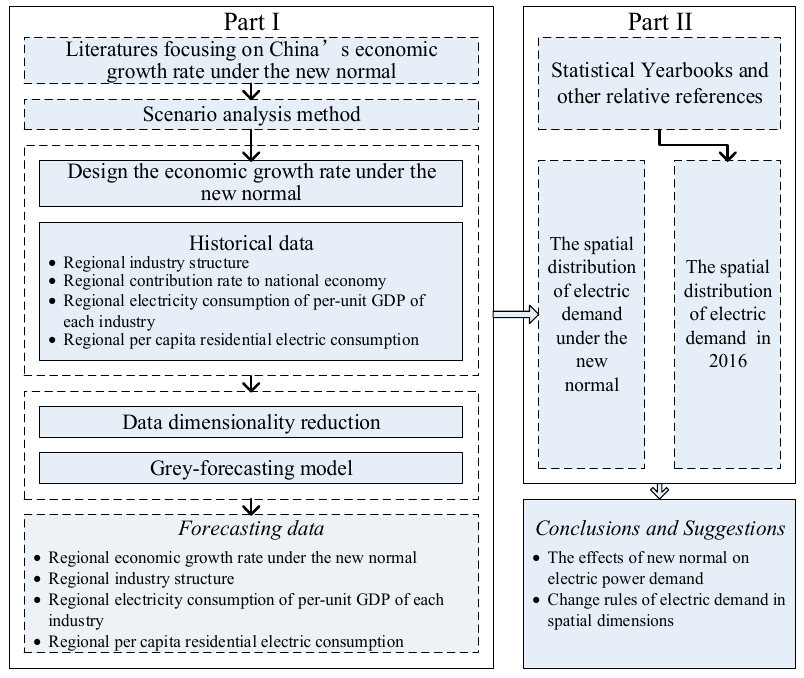
Figure 1. Model framework.